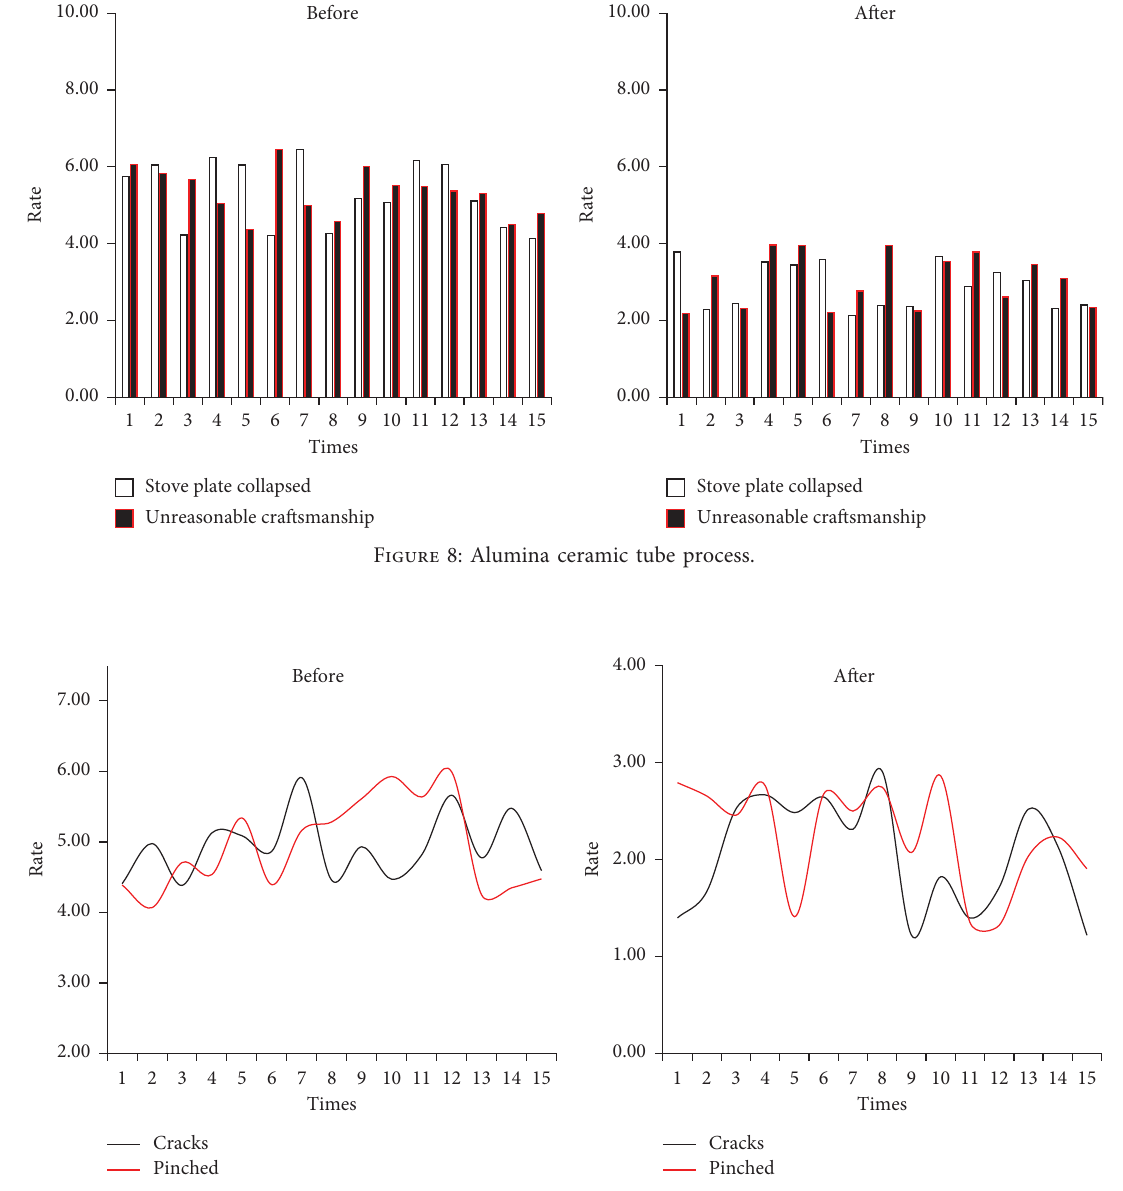
Figure 9: Finished alumina ceramic tube.